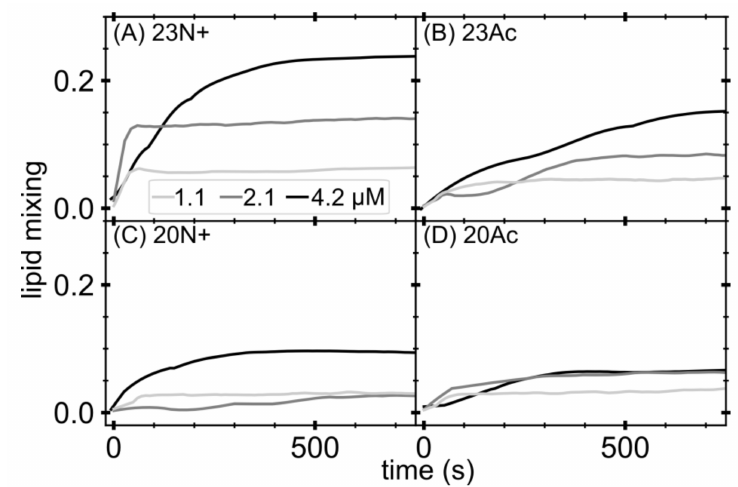
Figure 1. Lipid mixing studied by means of fluorescence energy transfer (FRET) occurring between donor and acceptor in large unilamellar vesicles induced by increasing amount of fusion peptides: ( A ) HAfp1-23; ( B ) HAfp1-23Ac; ( C ) HAfp1-20; and ( D ) HAfp1-20Ac. Lipid mixing calculated as percentage of liposomes fused, using solubilized liposomes in detergent as